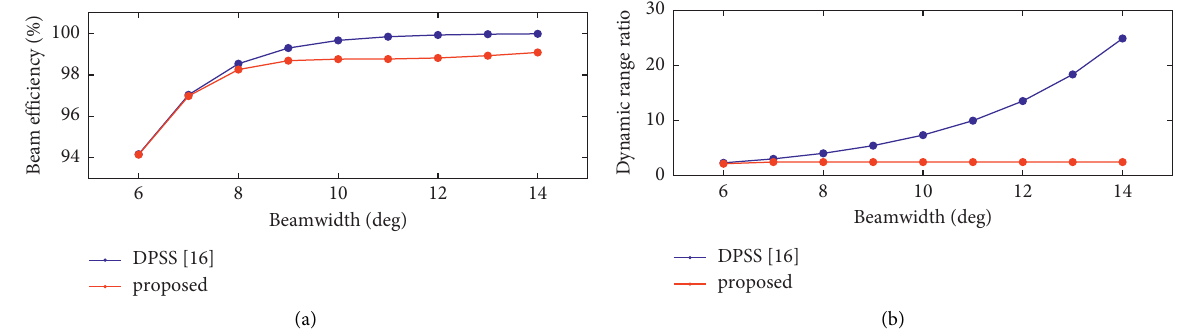
Figure 3: (a) Beam efciency and (b) Dynamic range ratio of pencil beam arrays with 30 elements obtained by minimization of SLP and DRR constrained to D � 2.5, compared to DRR-unconstrained design with maximum beam efciency [16].